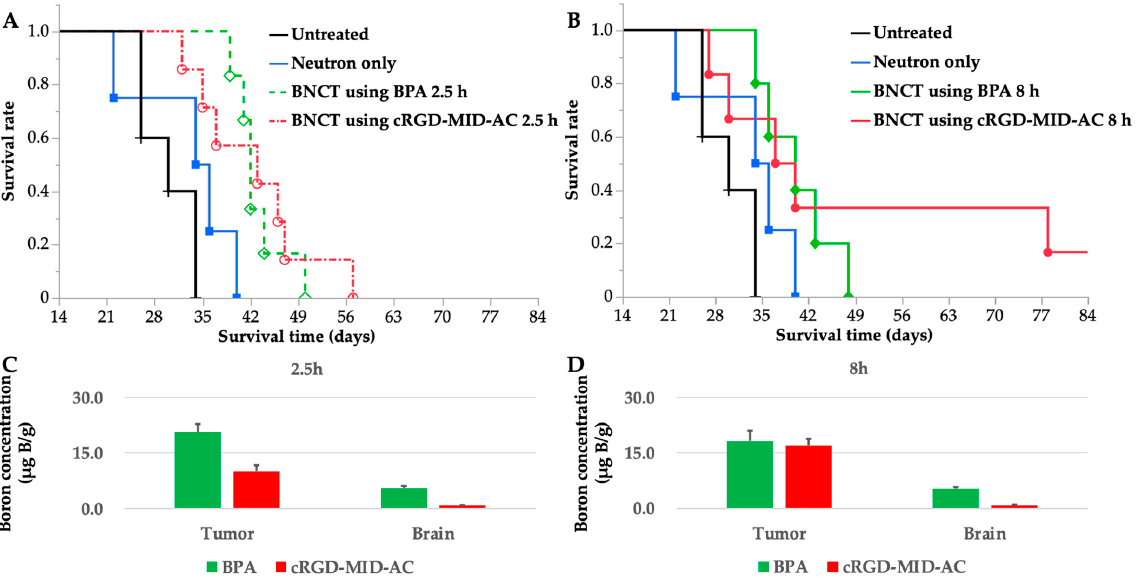
after neutron irradiation. Survival times (days) after implantation of F98 glioma cells are plotted. Six groups were created; untreated, neutron only, BNCT using boronophenylalanine (BPA) 2.5 h, BNCT using BPA 8 h, BNCT using cyclic RGD-functionalized closo -dodecaborate albumin conju- gates with maleimide (cRGD-MID-AC) 2.5 h, and BNCT using cRGD-MID-AC 8 h. ( A ) Kaplan–Meier survival curves for untreated, neutron only, BNCT using BPA 2.5 h, and BNCT using cRGD-MID-AC 2.5 h. ( B ) Kaplan–Meier survival curves for untreated, neutron only, BNCT using BPA 8 h,